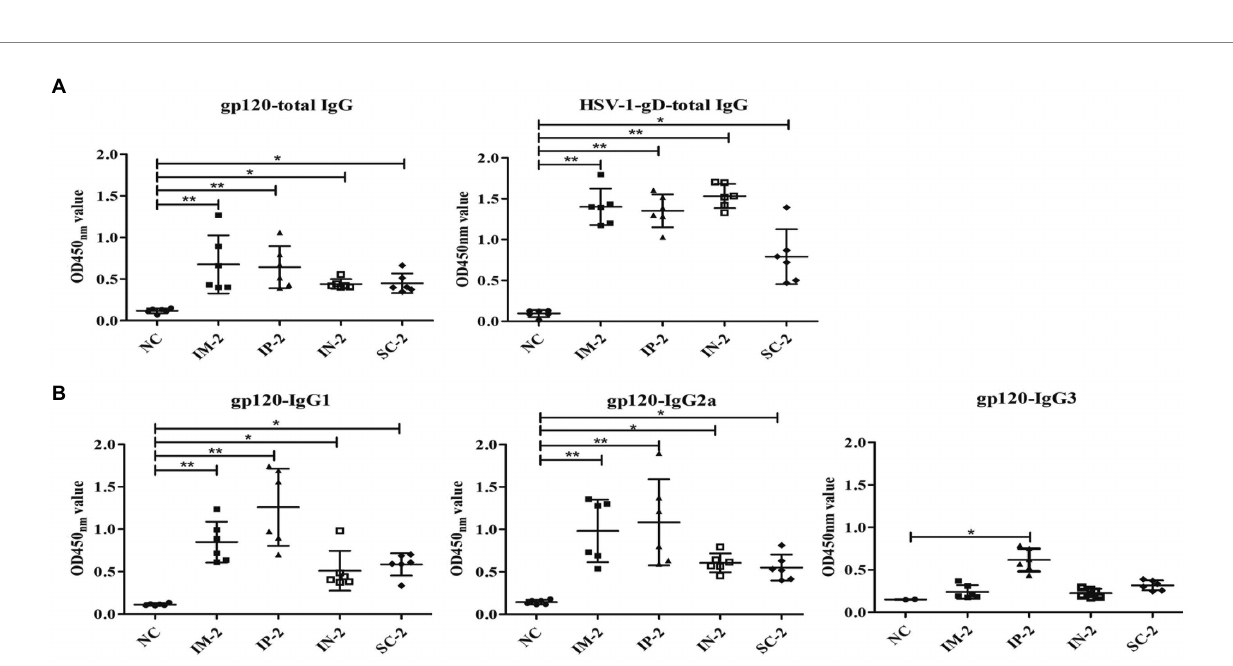
FIGURE 4 Antibody responses to different administration routes. Serum samples were collected from mice following different immunization routes 56 days after the first injection, and antigen specific humoral immune responses measured by ELISA. Pre-immune sera of each mouse were used as negative control. Serum dilution is 1:10 5 for HSV-1 gD, and 1:10 3 for all other antigens. (A) Total IgG responses specifically against gp120 and HSV-1 gD. (B) IgG subtype antibodies against gp120, including IgG1, IgG2a, and IgG3. Mock-infected mouse served as the negative control (NC). * p < 0.05, ** p <